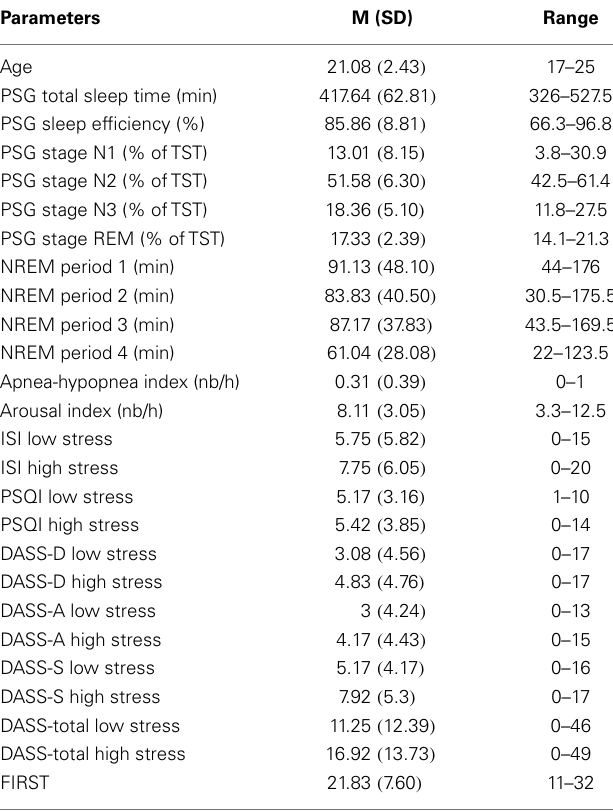
Table 1 | Characteristics of participants ( N = 12, 10 females)